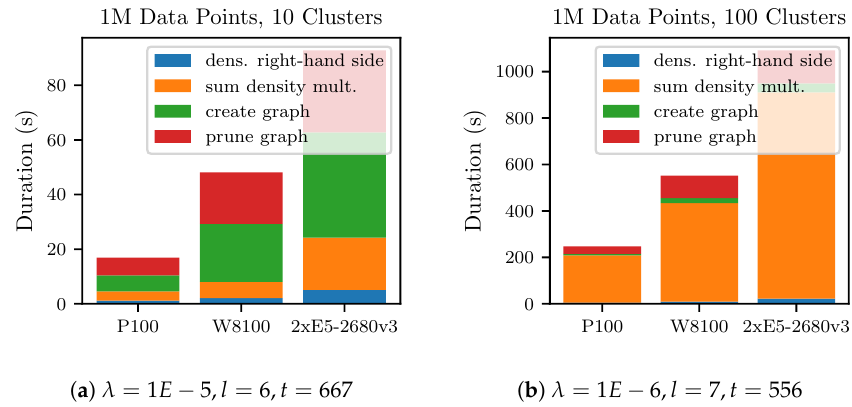
Figure 6. The duration of the node-level experiments with one million data points. Because the 1M-100C dataset requires a larger grid, the density estimation takes up most of the overall runtime.